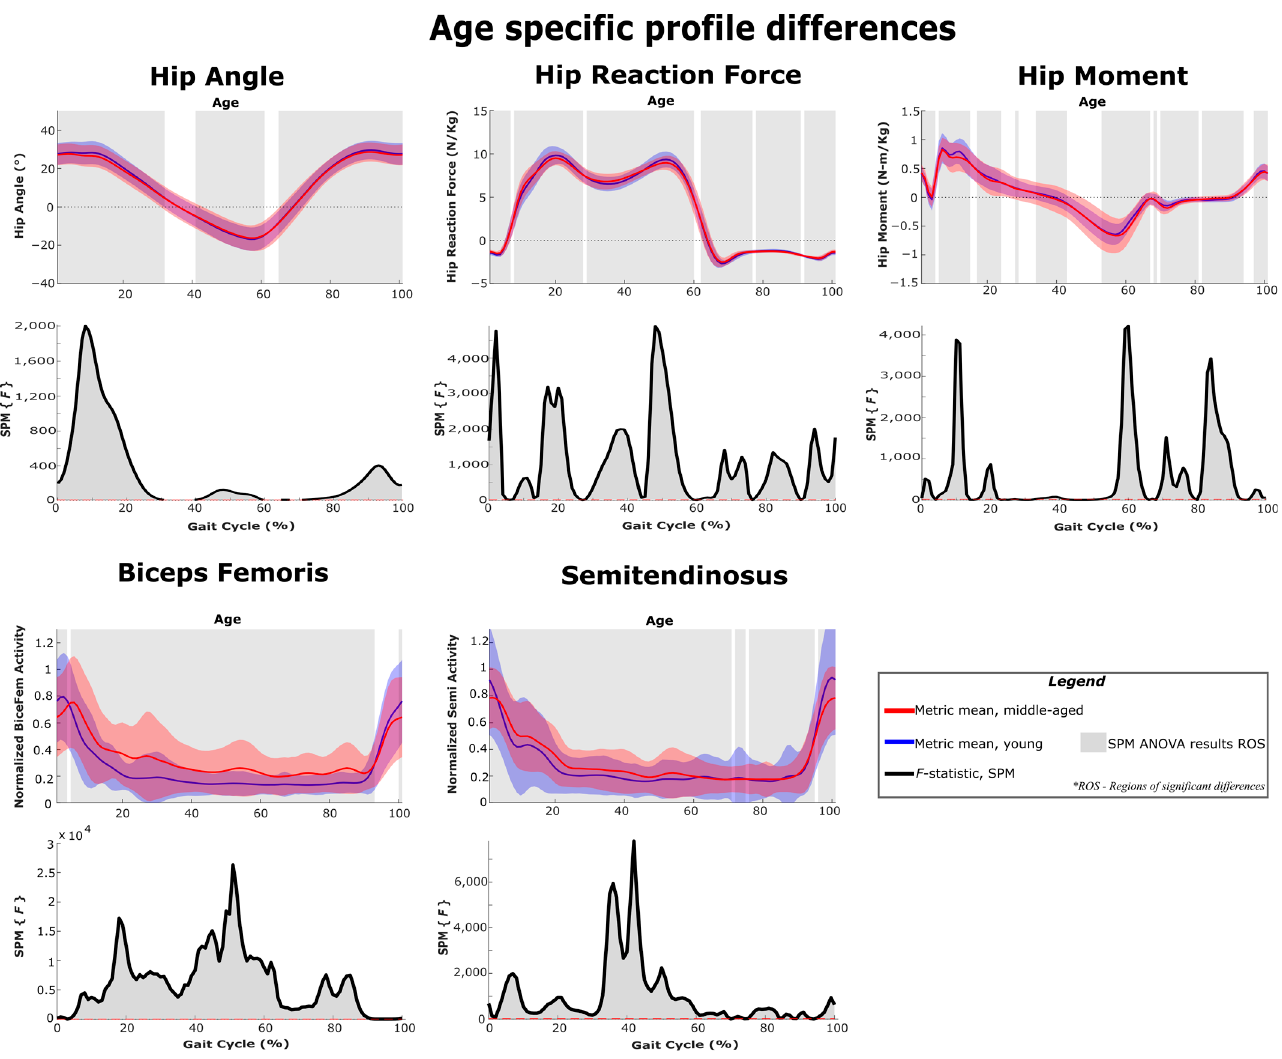
Figure 13. SPM ANOVA results and age-specific differences between the younger and middle-aged cohorts. Joint parameters are primarily related to the hip joint. The F -statistic is qualitatively identical to the effect size and can be used as an indicator of practical significance.